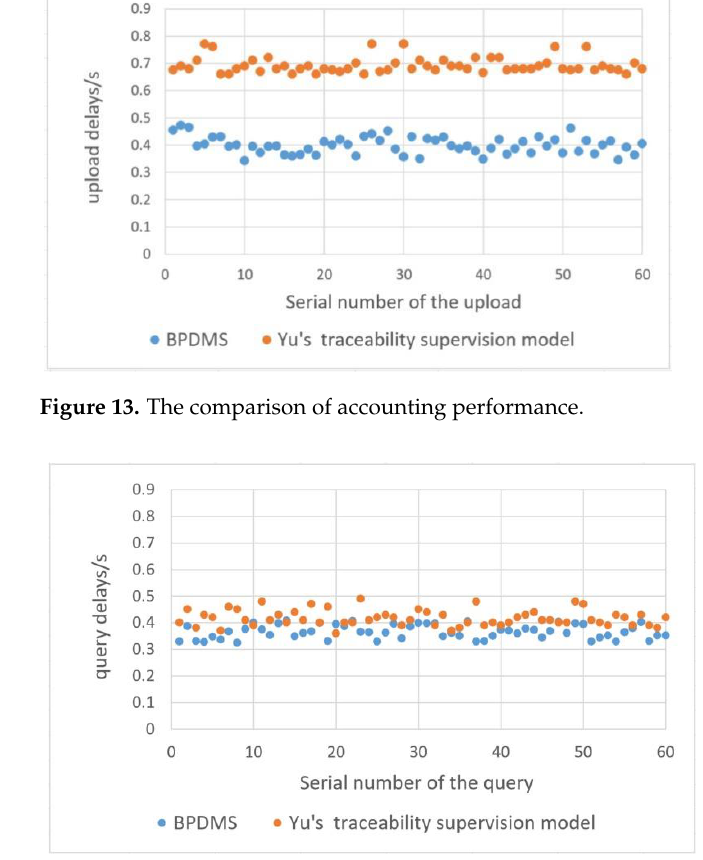
Figure 14. The comparison of query delay.